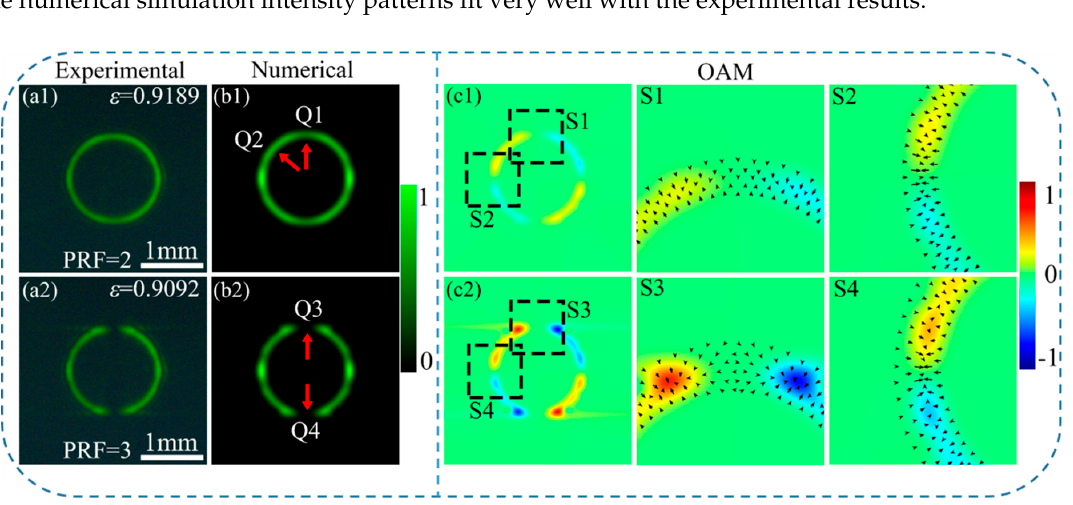
Figure 3. Comparison of CSOVs with phase reconstruction factor (PRF) equaling to an odd and an even, respectively. ( a1 ) and ( a2 ) are experimental intensity, ( b1 ) and ( b2 ) are numerical simulation intensity. ( c1 ), ( c2 ) and ( S1 – S4 ) are the numerical simulation OAM distribution. In the fourth and fifth columns, the arrows visualize the gradient force. The ε values represent the mode purity of the generated CSOVs. The joints in the intensity rings mean that the border lines between quadrants in Figure 1a1,a2.